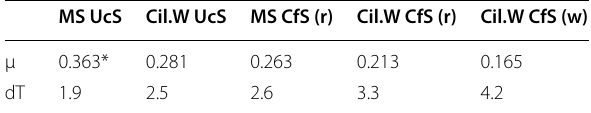
Table 2 Growth kinetic parameters of C. vulgaris inferred from a 5 day‑growth period in